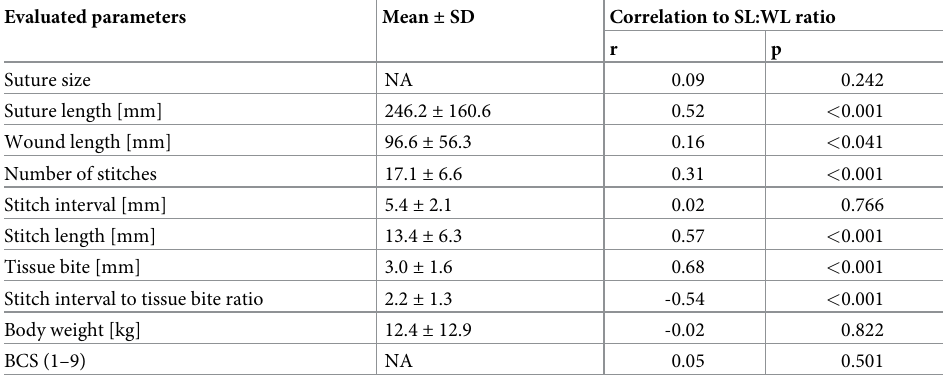
suture parameters, mean SI:TB ratio and morphometric data are shown in Table 4. All correla- tions are described according to the study by Mukaka et al. [27]. A moderate negative correla- tion was found between the mean SI:TB ratio and the SL:WL ratio. Moderate positive correlations were found between the SL:WL ratio and the mean TB, mean STL and SL. A low positive correlation was found between the number of stitches and the SL:WL ratio. A negligi- ble correlation was found between the WL and the SL:WL ratio. The mean SI, body weight, BCS and suture size showed no correlations with the SL:WL ratio. Influence of groups and species on SL:WL ratio, suture parameters, mean SI:TB ratio, and morphometric data. Descriptive statistics and correlation coefficients divided by species and groups for the suture parameters, mean SI:TB ratio and morphometric data are presented in Table 5. Higher correlations were found in the group Diplomates suturing cats than in the other groups (namely, diplomates suturing dogs and residents suturing both dogs and cats). High negative correlations between the SL:WL ratio and mean SI:TB ratio were found in dogs and cats performed by the group Diplomates and in dogs performed by the group Residents. Also high negative correlations between the SL:WL ratio and mean TB were found in dogs and cats performed by the group Residents and in cats performed by the group Diplomates. The mean SI and BCS showed no correlations. Table 4. Correlation between the SL:WL ratio and different parameters. Evaluated parameters